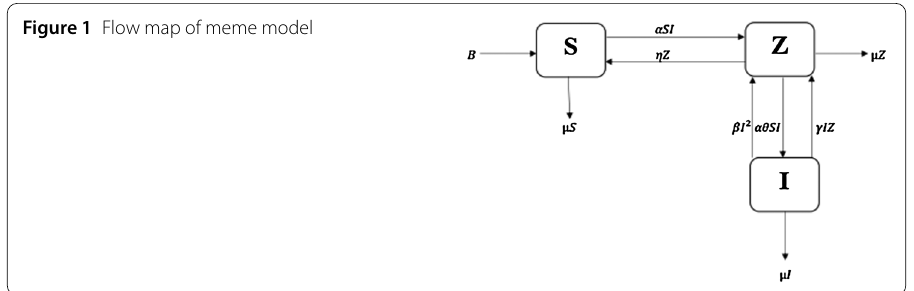
Figure 1 Flow map of meme